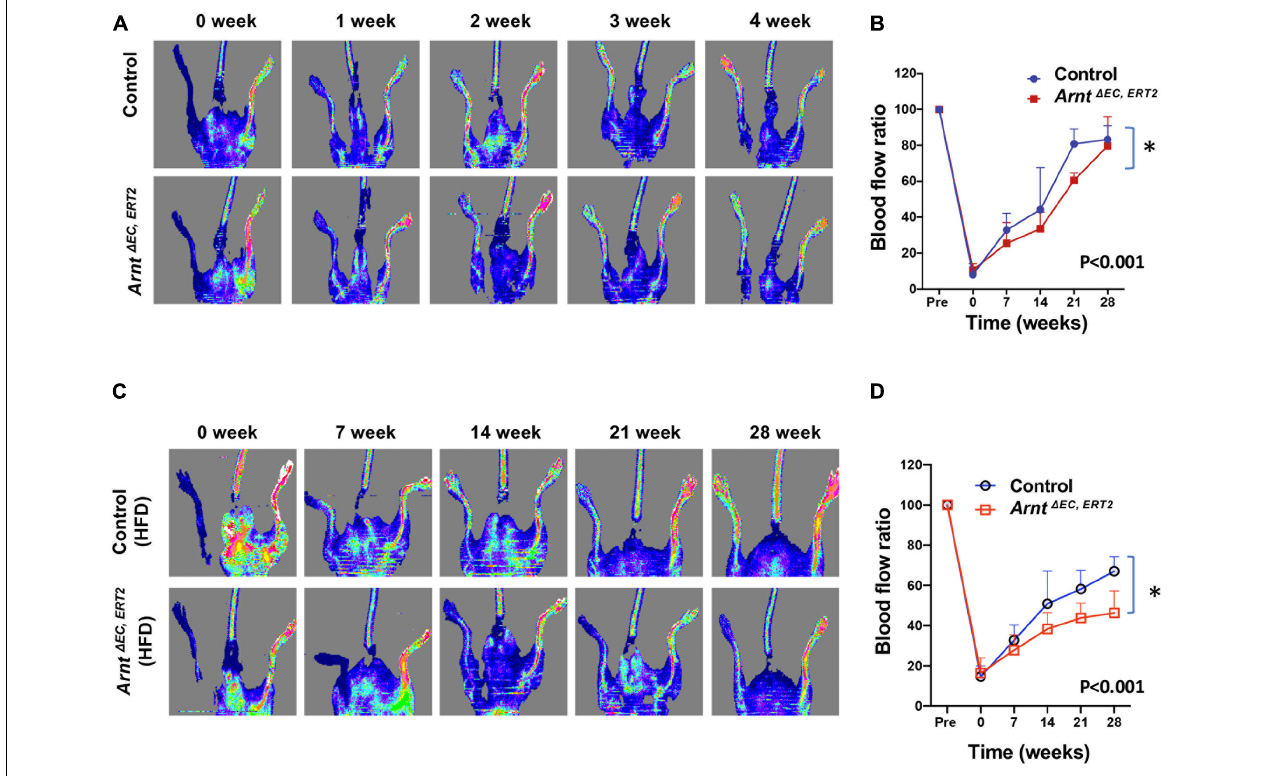
FIGURE 3 | Laser Doppler blood flow analysis for the ischemic hindlimb of Arnt (cid:49) EC , ERT2 or wild-type control mice with and without high-fat diet (HFD). (A) Laser Doppler perfusion imaging of blood flow in the ischemic hindlimb measured in control and Arnt (cid:49) EC , ERT2 mice fed with a standard diet. Laser Doppler perfusion imaging of blood flow in the ischemic hindlimb was measured immediately (time 0) and 1–4 weeks after surgery. Blood flow is color-coded, with normal perfusion indicated by red and a marked reduction in blood flow indicated by blue. (B) Quantitation of blood flow is expressed as the ratio of blood flow in the ischemic (left) hindlimb to that in the normal (right) hindlimb. (C) Laser Doppler perfusion imaging of blood flow in the ischemic hindlimb measured in control and Arnt (cid:49) EC , ERT2 diabetic mice induced with 8 weeks of HFD. (D) Quantitation of blood flow as in B. Data are means of values from 8–11 animals per group. ∗ P < 0.01 versus corresponding value for wild-type